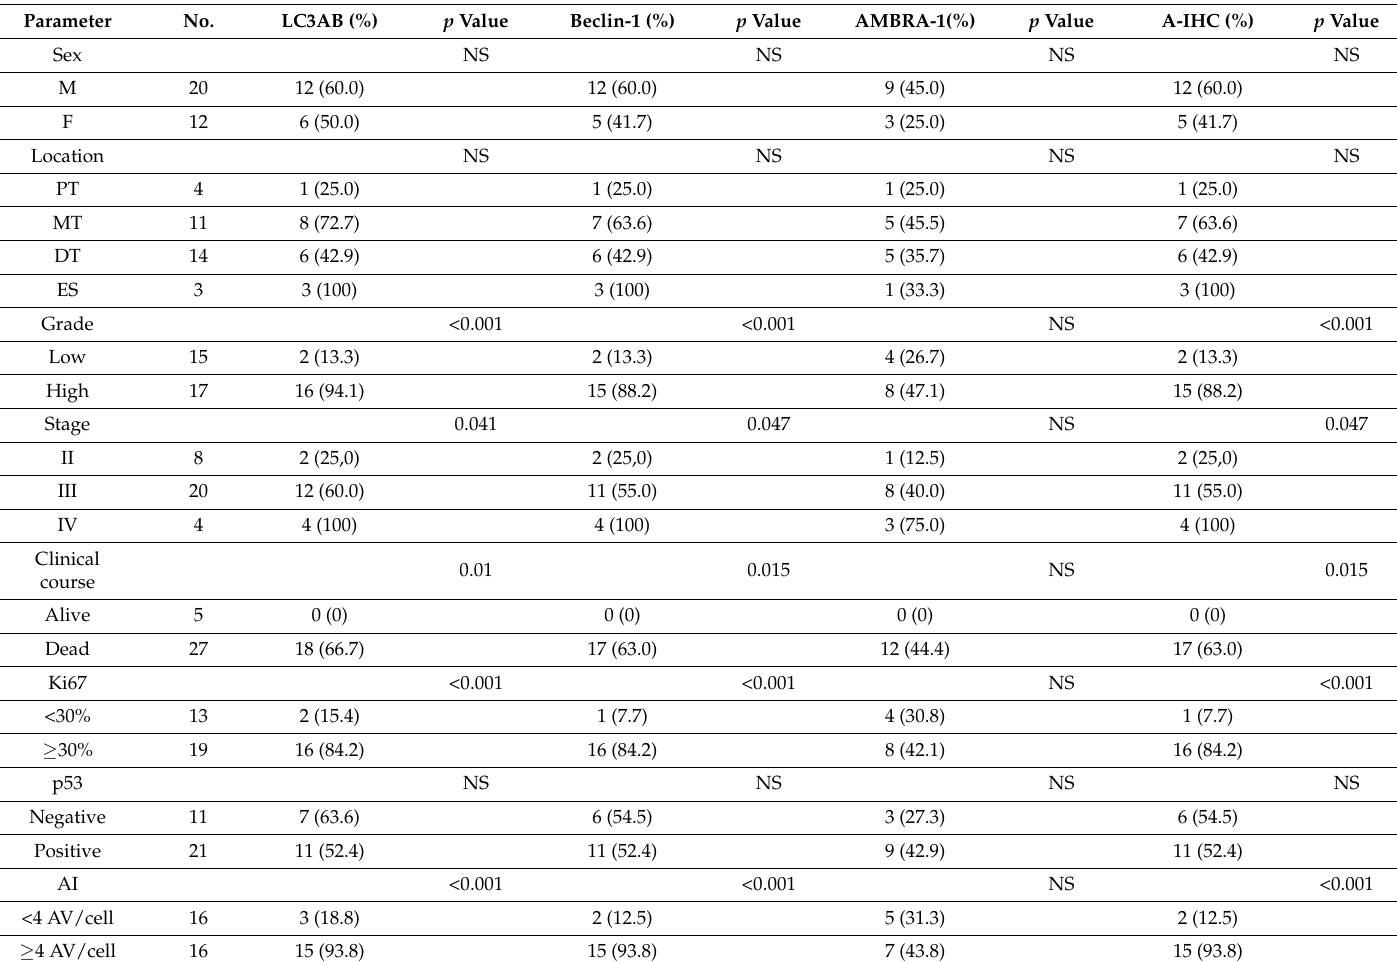
Table 1. Clinico-pathological parameters and corresponding immunoexpression autophagy-related proteins in gastric carcinomas